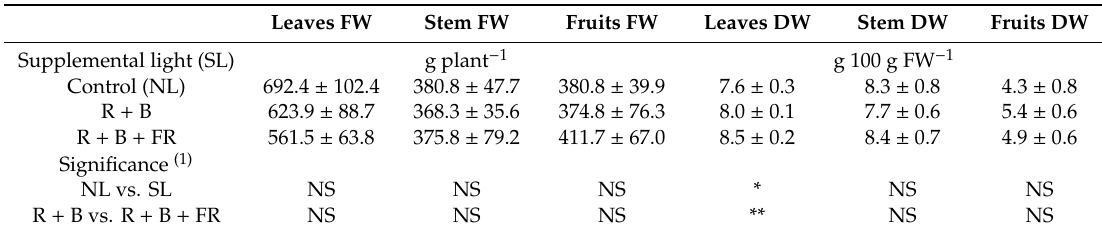
Table 1. E ff ects of light conditions on fresh weight (FW) and dry weight (DW) of fruits, leaves, and stems. Values are average ± DS of three replications 67 DAT. Leaves FW Stem FW Fruits FW Leaves DW Stem DW